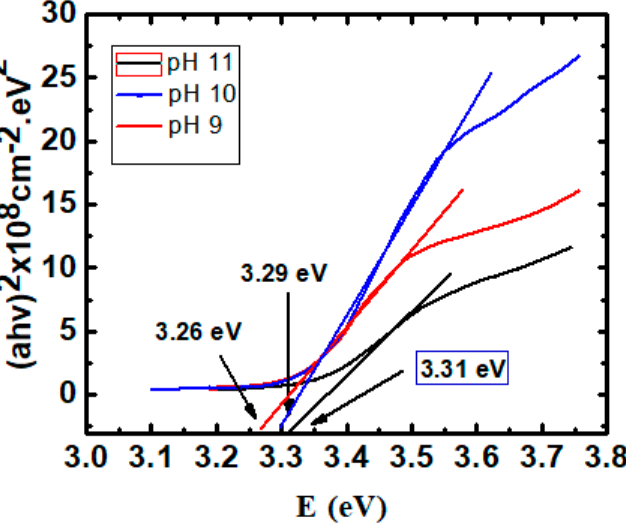
Figure 2. The plot of ( α h ν ) 2 versus ( h ν ) of ZnO nanostructured thin films for pH 9, pH 10, and pH